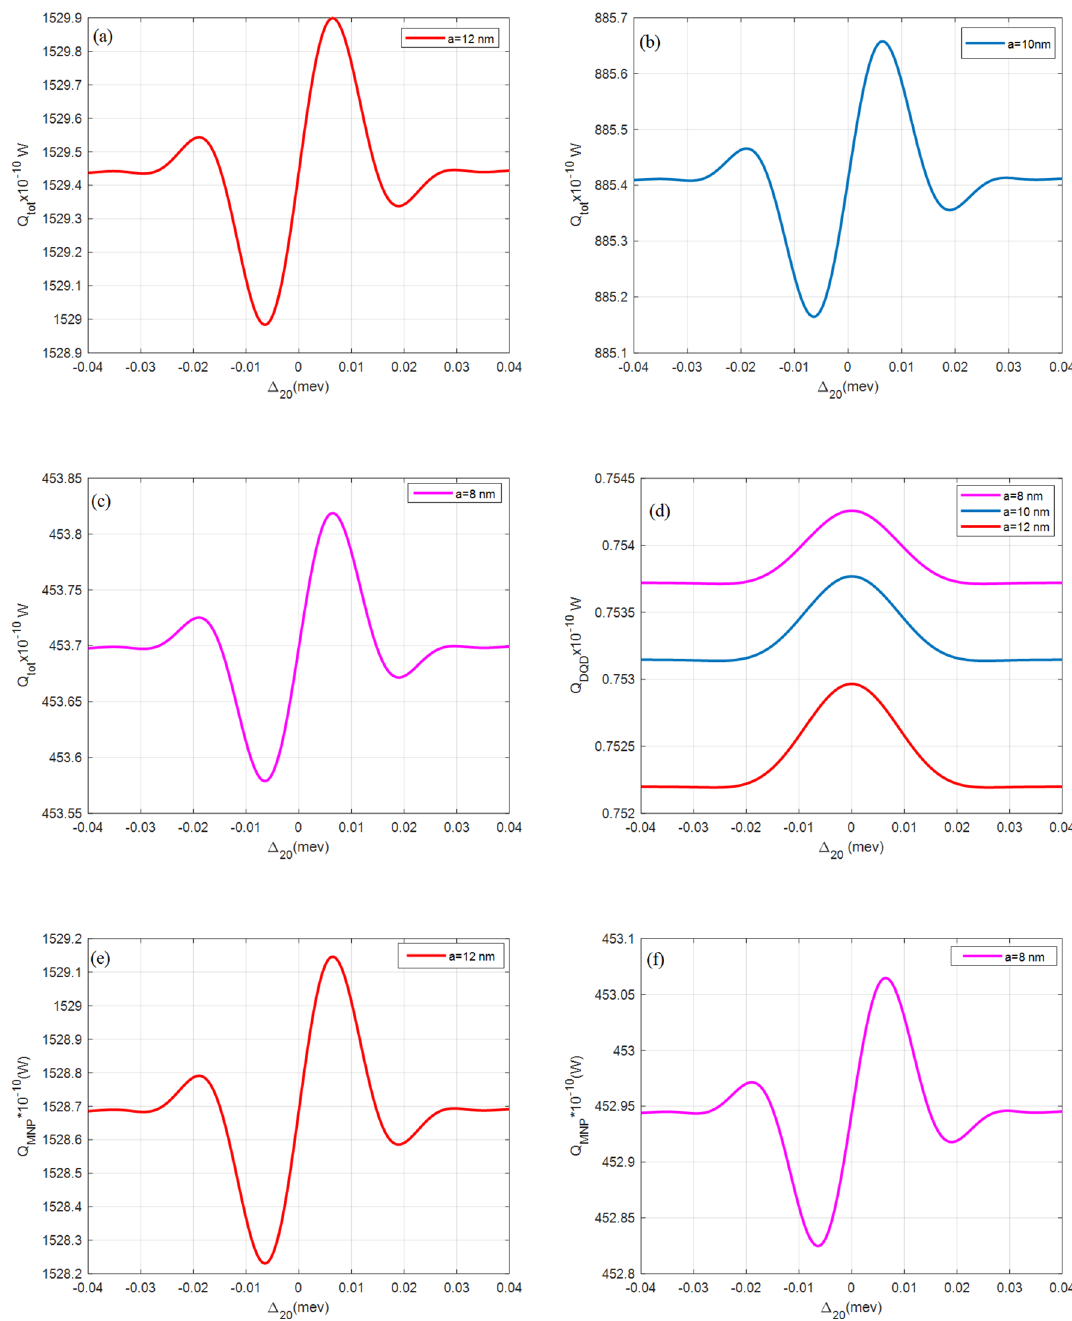
Figure 4. The absorption rates of the DQD-MNP hybrid system at R = 20nm . The total ( Q tot ) absorption rate is in ( a ) a = 12nm , ( b ) a = 10nm , and ( c ) a = 8 nm . The DQD ( Q DQD ) is in ( d ), and then MNP ( Q MNP ) is in ( e ) a = 12nm , and ( f ) a = 8 nm . In these figures (cid:31) 0 02 = 0.09meV , � 0 13 = 1.8GeV, T 01 = 30 γ 0 , T 32 = 8 γ 0